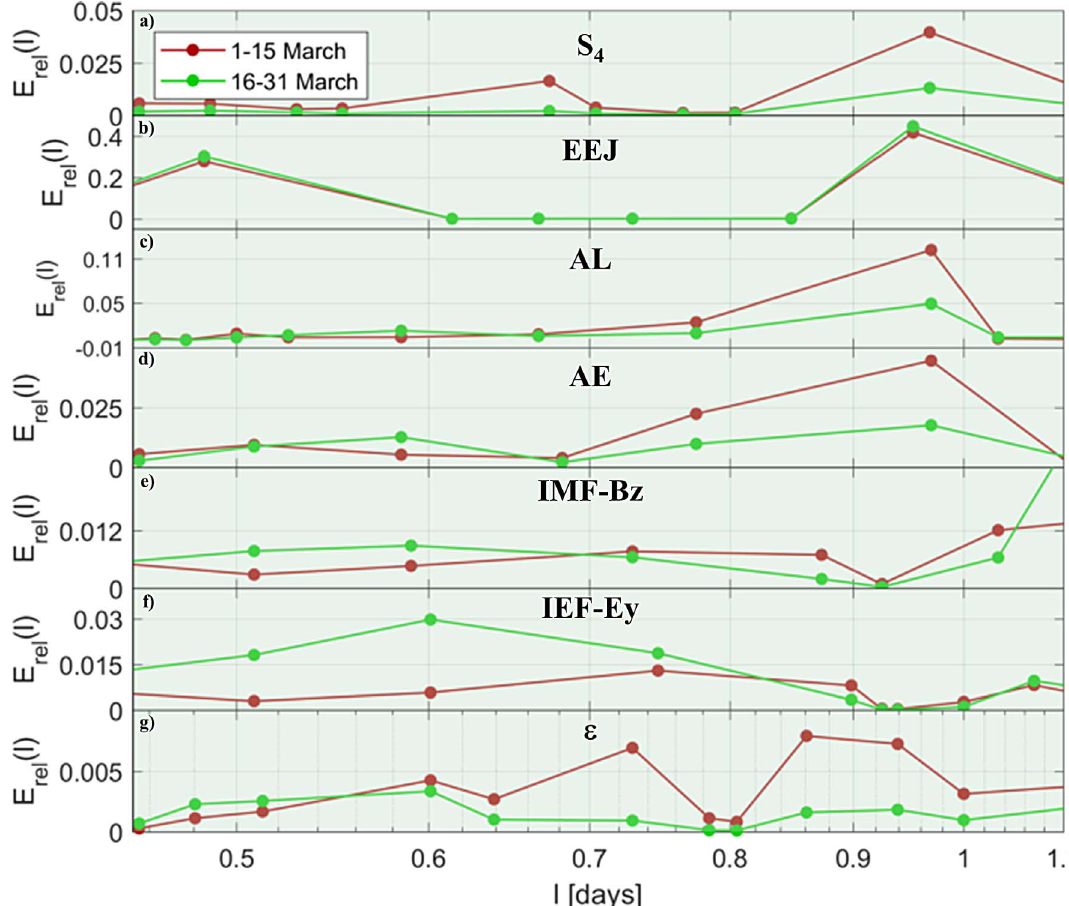
Fig. 6. Zoom of Figure 5 in the high-period range, up to 1.1